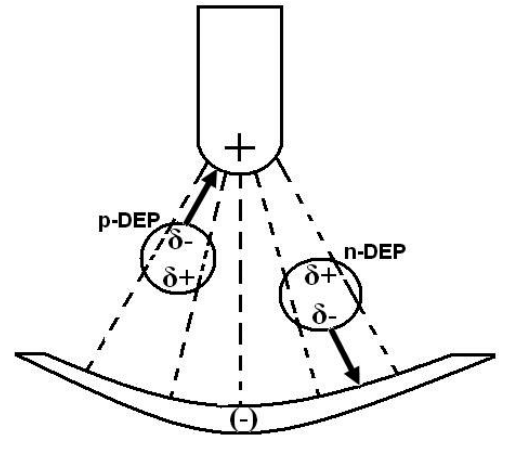
Fig. 1 – Two different particles in a non-uniform electric field. The particle on the left is more polarizable than the surrounding medium and is attracted towards the strong field at the pin electrode (p-DEP), whilst the particle of low polarizability on the right is directed away from the strong field region